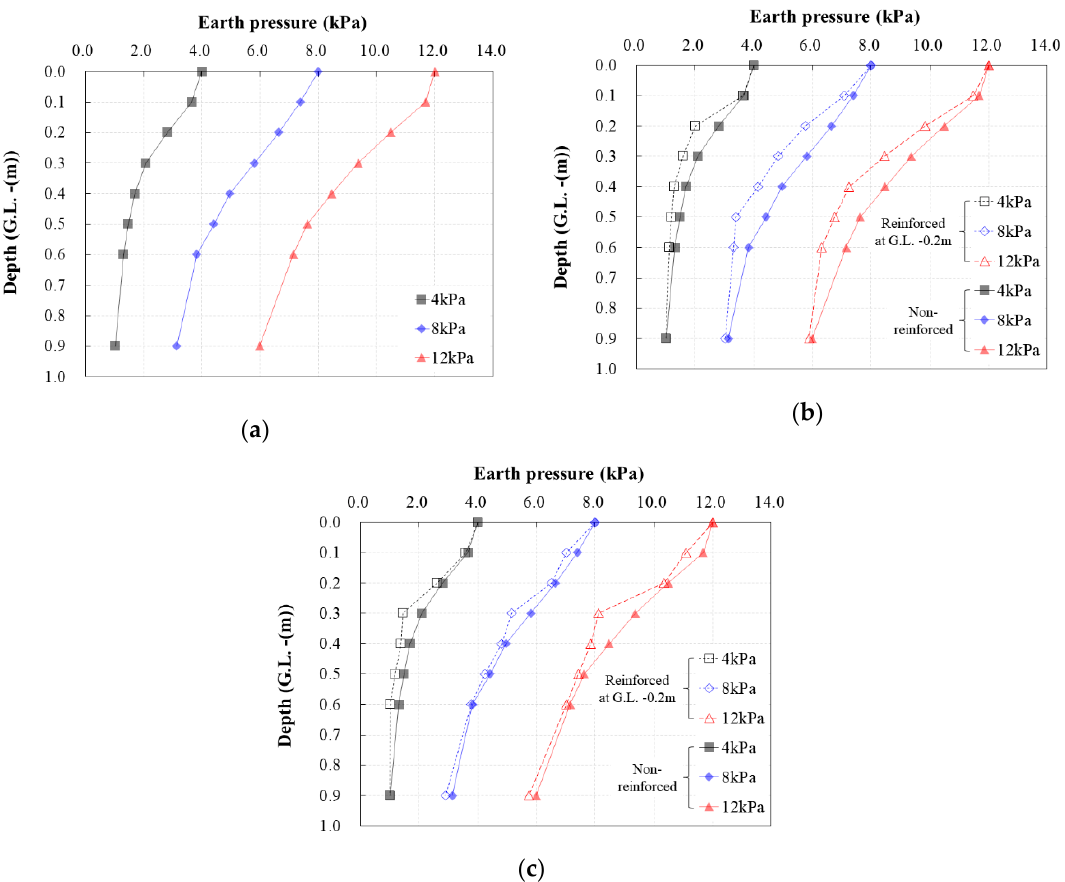
Figure 5. The relationship between the earth pressure and depth, according to the load step: ( a ) non-reinforced; ( b ) reinforced at G.L. − 0.1 m; ( c ) reinforced at G.L. − 0.2 m.